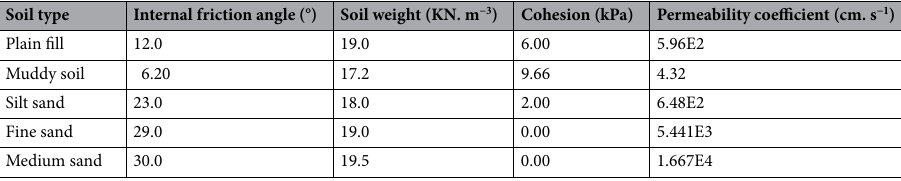
Table 1. Soil layer parameter table.